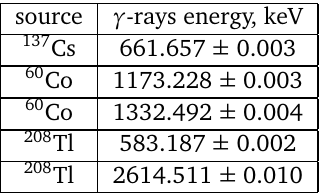
Table 1: The list of calibration